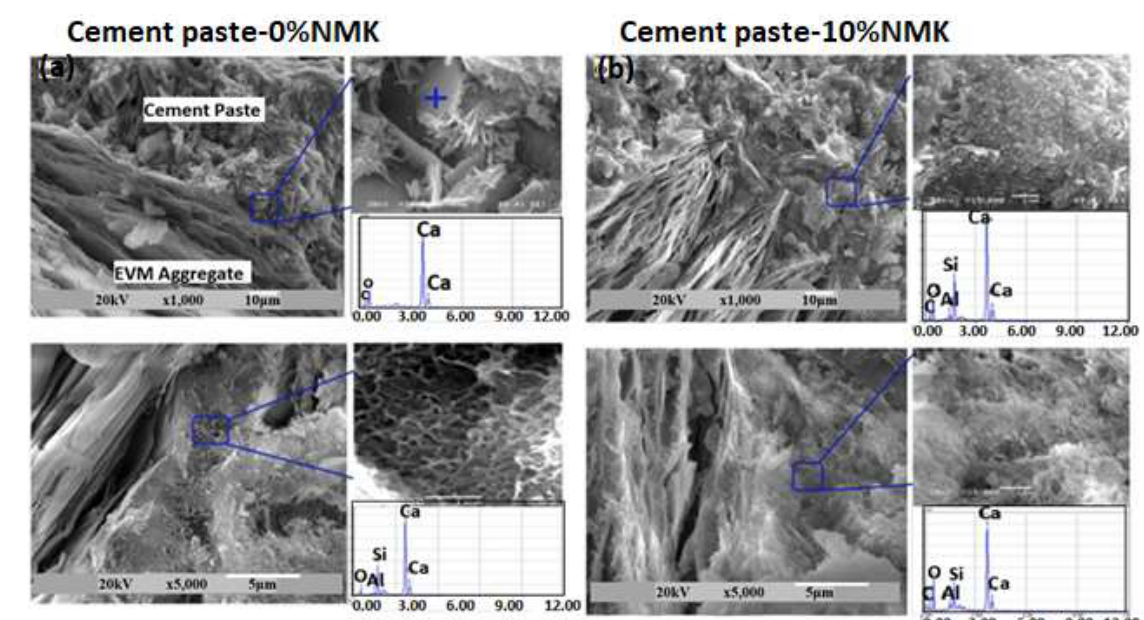
Figure 4. SEM pictures and EDAX of ( a ) 0% NMK and ( b ) 10% NMK [53].